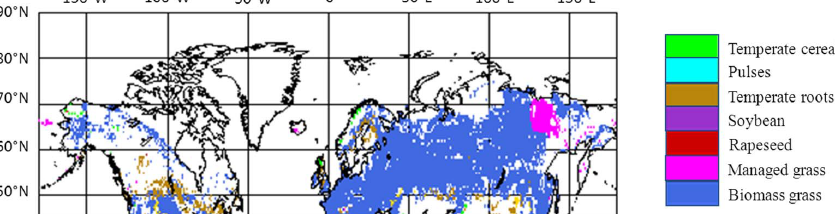
Fig. 5. The land use pattern at the end of the 21st century for the UNLIM scenario with areas having extremely low yielding areas (less than 2tDMha − 1 ) masked